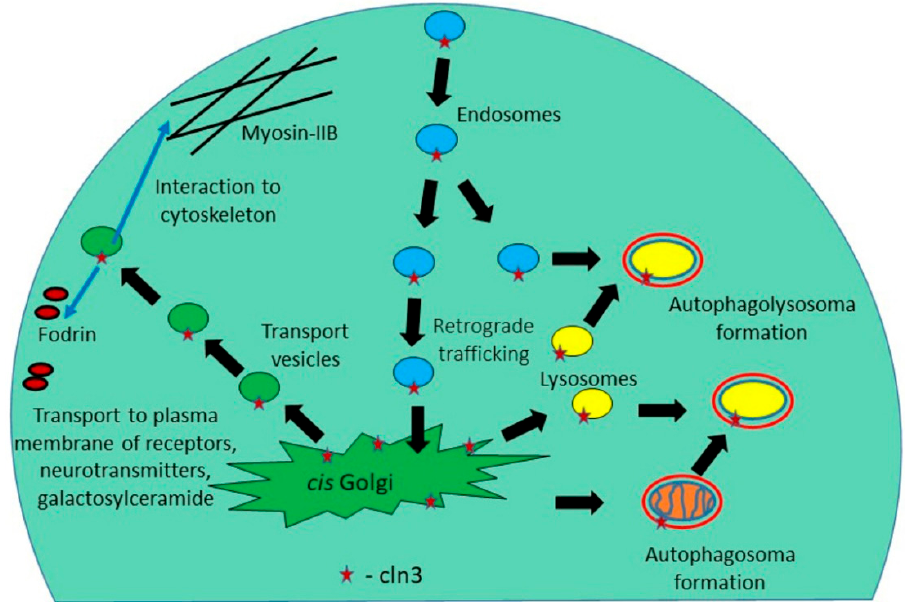
Figure 2. The CLN3 protein mediates anterograde and retrograde trafficking of Golgi network—plasma membrane, participates in the formation of endosomes, autophagosomes, and lysosomes.